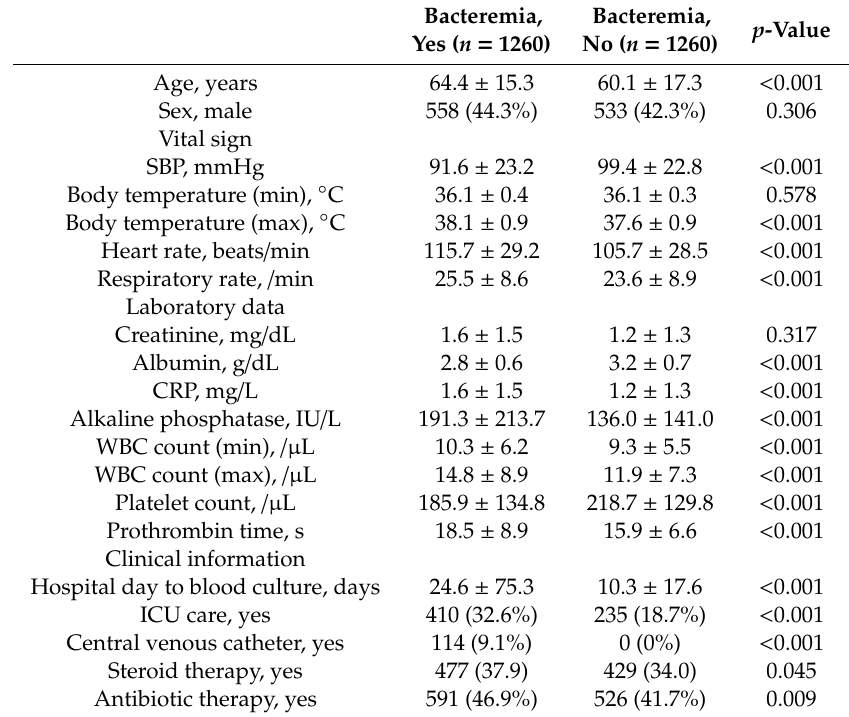
Table 1. Comparison of the clinical characteristics of two groups classified according to bacteremia.